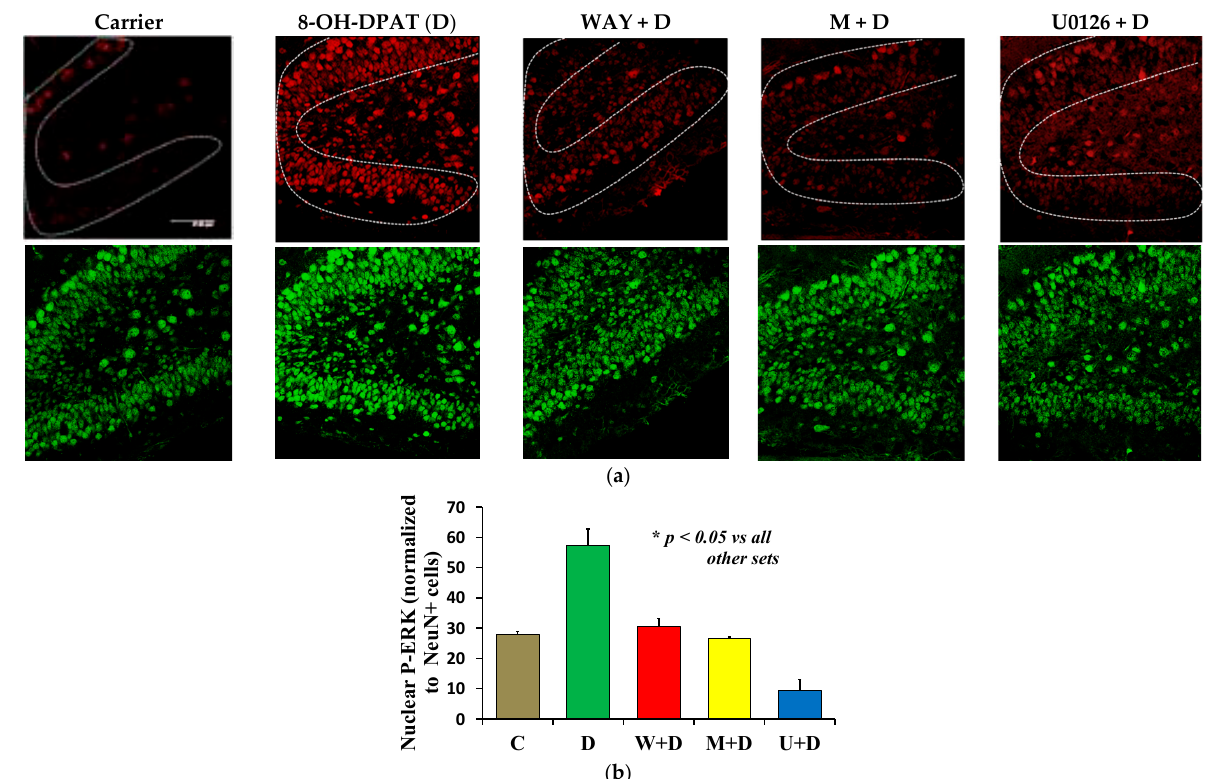
Figure 3. Stimulated 5-HT 1A -R causes PKC ε -mediated activation of ERK1/2 in P6 DG. One hour after intra-hippocampal infusion of drugs, the hippocampi from P6 pups were processed for P-T 202 , Y 204 -ERK (P-ERK) (red), NeuN (green) double staining. ( a ) 8-OH-DPAT (D) (100 nM) treatment caused an increase in nuclear P-ERK, which was suppressed in the presence of the MEK inhibitor U0126 (U), and also a selective PKC ε inhibitor (Myr- ε V1-2) (M). ( b ) Quantification of the number of P-ERK (+) nuclei was performed from three sections (every sixth) from each of the dorsal, dorso-ventral, and ventral regions (nine sections in total per mouse pup). Three to four mice per treatment group were used (see results for details). The count of P-ERK (+) nuclei within the DG (in the dotted contour) for each section was normalized to the count of NeuN (+) nuclei and then the normalized mean from these nine sections was used for each mouse to conduct statistical